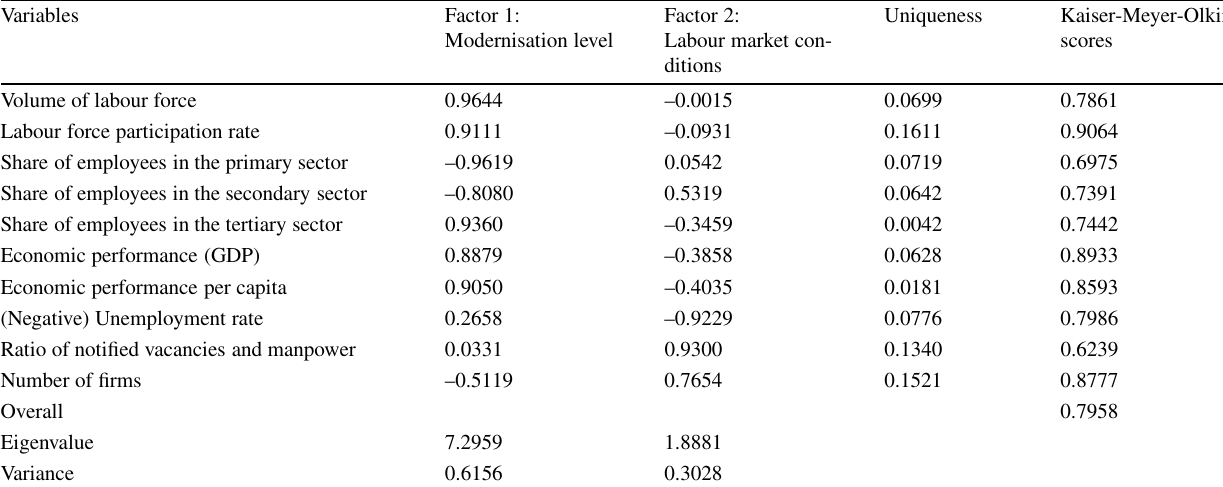
Table 2 Factor loadings (pattern matrix) and unique variances